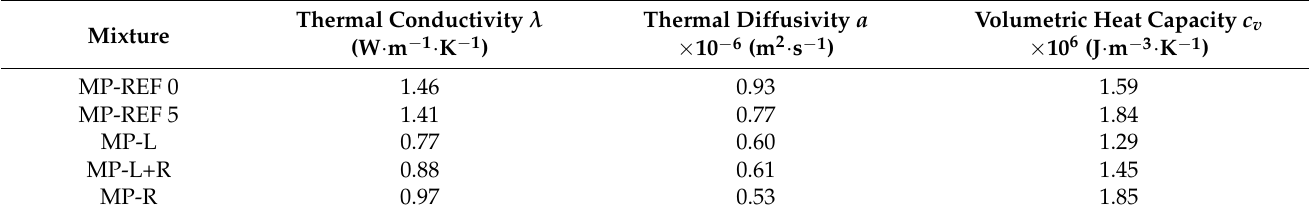
Table 9. Thermophysical properties of the hardened mortars.